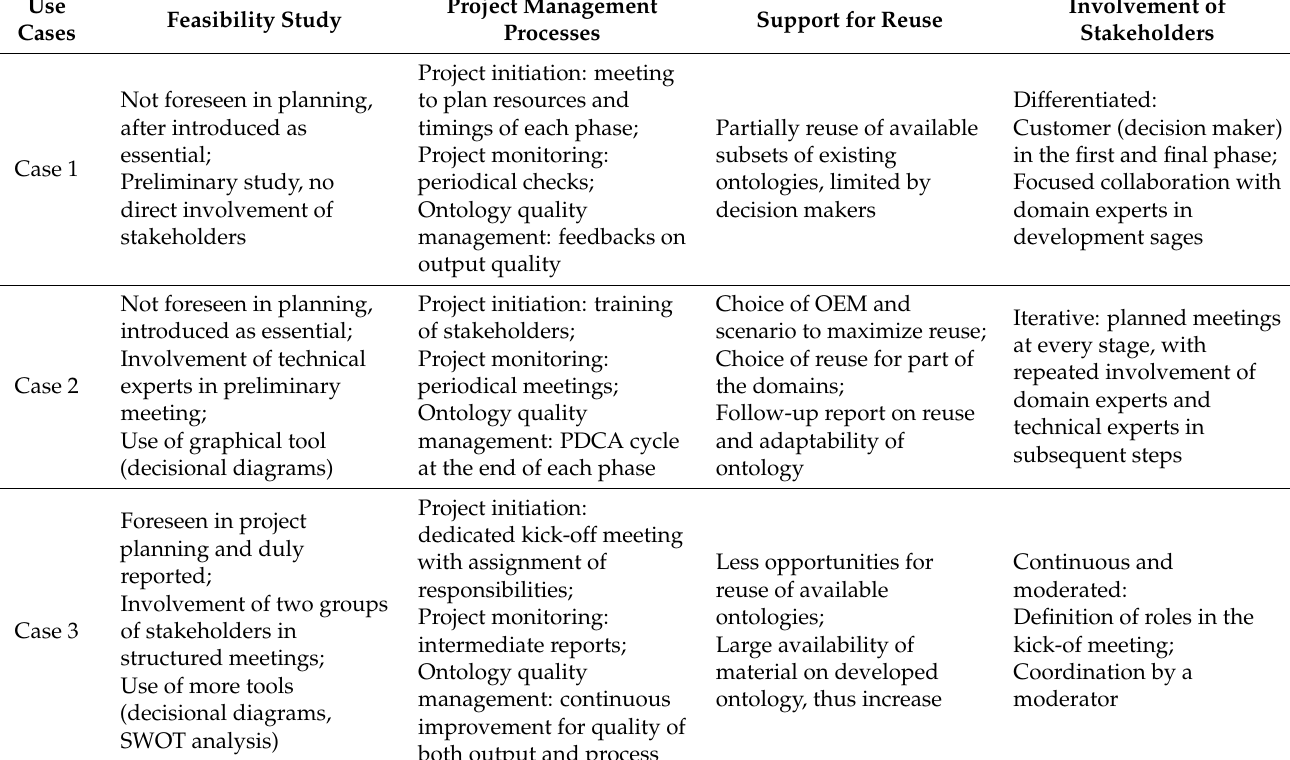
Table 3. Main challenges deriving from OEMs’ shortcomings in the three use